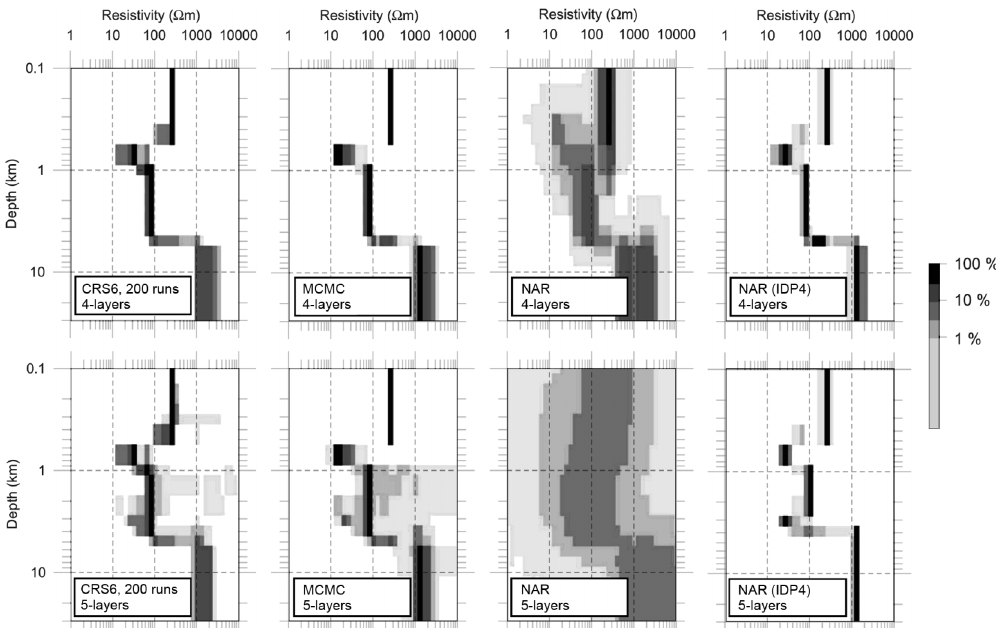
Fig. 3. Gray-shade plots of stacked models produced by CRS, MCMC and NAR runs applied to DSI data set with 5% of Gaussian noise. Top row of panels show the results for a 4-layer model approximation, bottom pan- els are for inversion with 5-layer models. The degree of gray color indicates the relative number of models that pass through 0.1 × 0.1 sized cells in the log ρ − log z